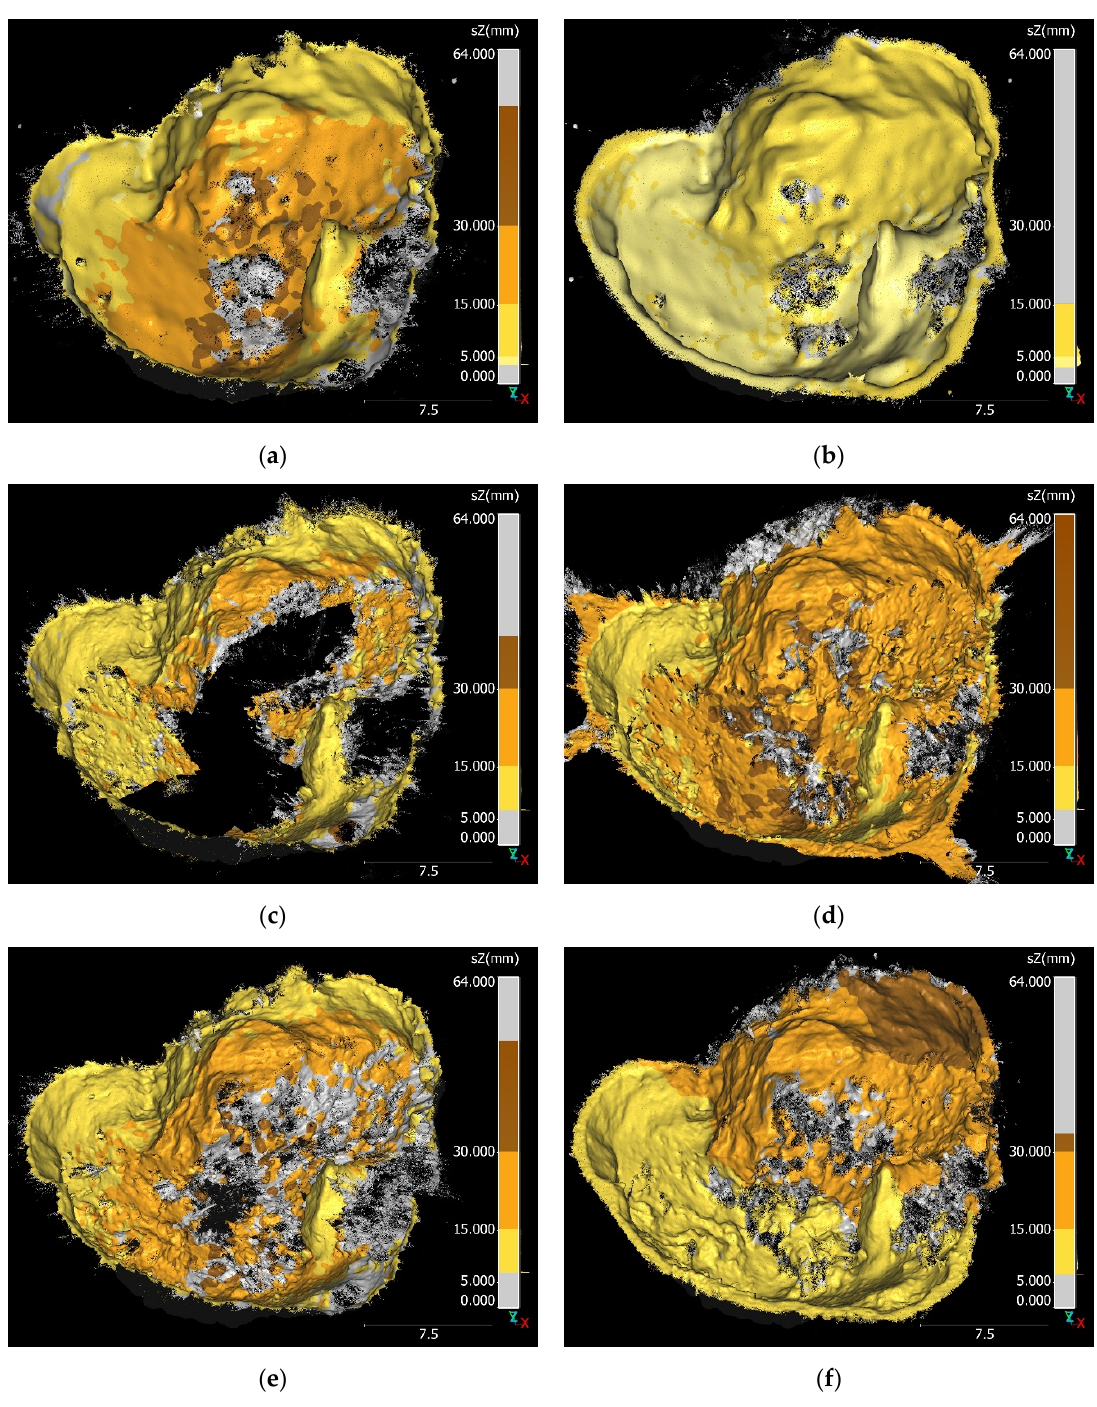
Figure 2. Vertical precision maps for the point clouds of the 2017 to 2019 terrestrial ( a ) Terrestrial 2017 precision map ( σ Z), ( c ) Terrestrial 2018 precision map ( σ Z), ( e ) Terrestrial 2019 precision map ( σ Z) and aerial ( b ) Aerial 2017 precision map ( σ Z), ( d ) Aerial 2018 precision map ( σ Z), ( f ) Aerial 2019 precision map ( σ Z) imagery. Gray color indicates areas where no point precision estimate was available from the interpolation from the sparse point cloud. Note that in these areas, also, no detectable change can be derived as no local level of detection is available. Additionally, please note the different minimum and maximum precision estimate value of each point cloud as indicated by the colors shown in the color scale.